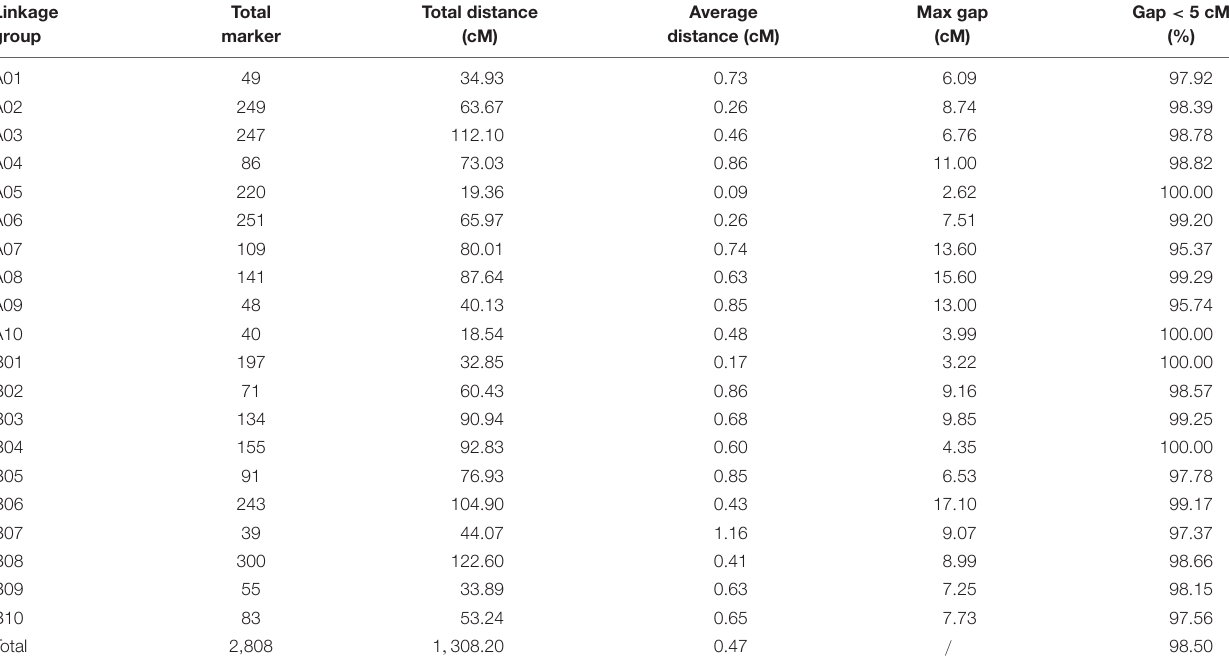
TABLE 5 | Basic characteristics of the 20 LGs constructed from the RIL population. Linkage